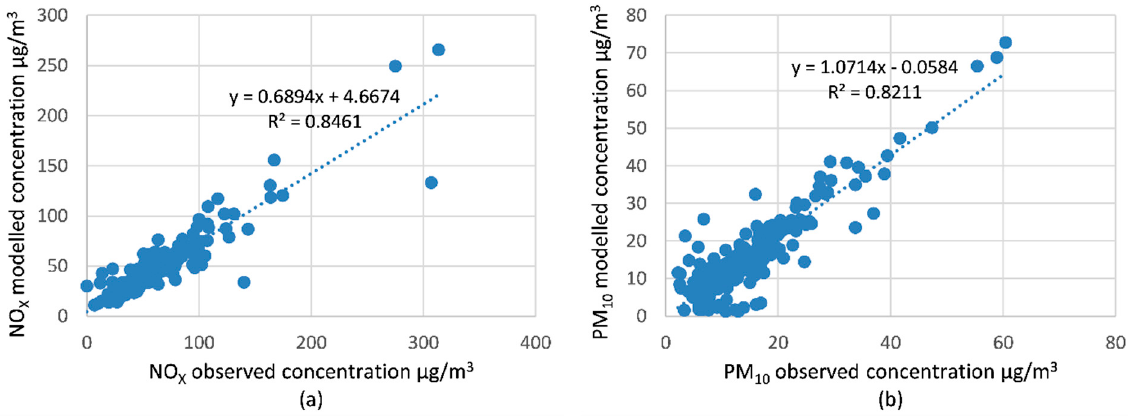
Figure 4. Modelled vs. observed concentrations for ( a ) NO X and ( b ) PM 10 daily average concentration in 2013.